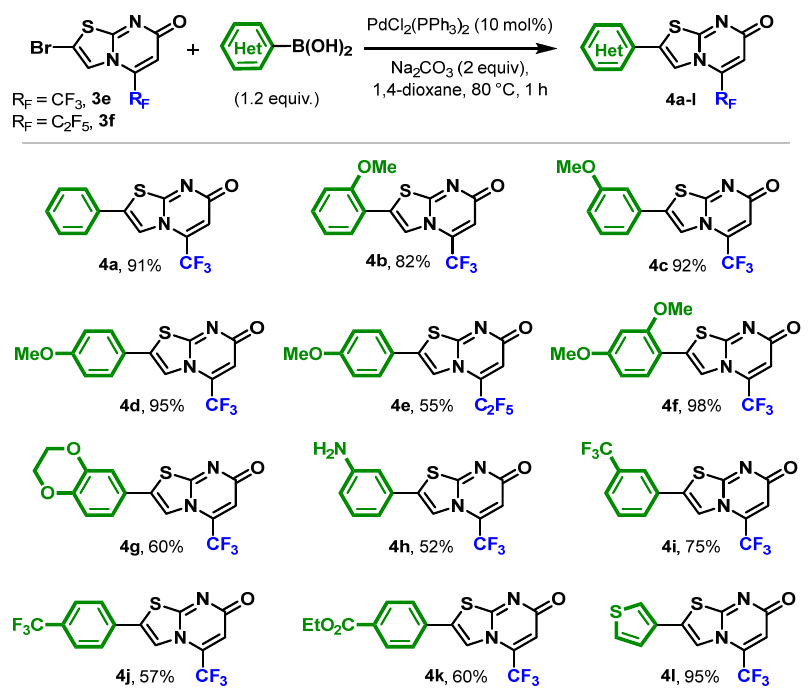
Scheme 2. Behavior of 2-bromo-5-fluoroalkylthiazolo[3,2- a ]pyrimidin-7-ones in the Suzu- ki-Miyaura